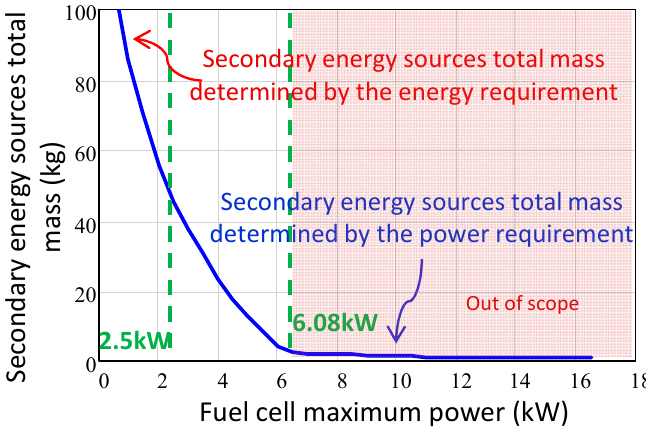
Figure 8. Secondary energy sources total mass (kg).